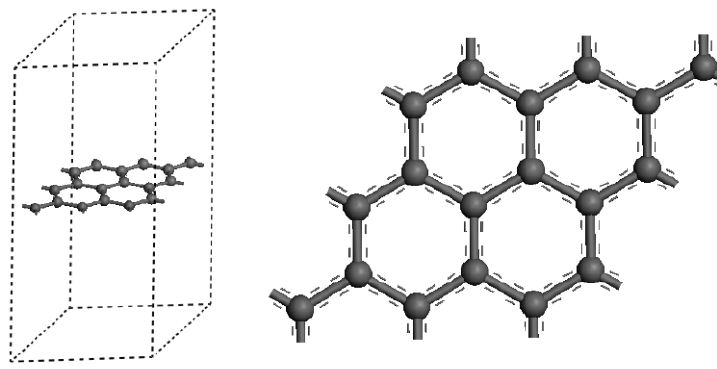
Figure 2. The model diagram of supercell of Ni or Cu coated graphene.